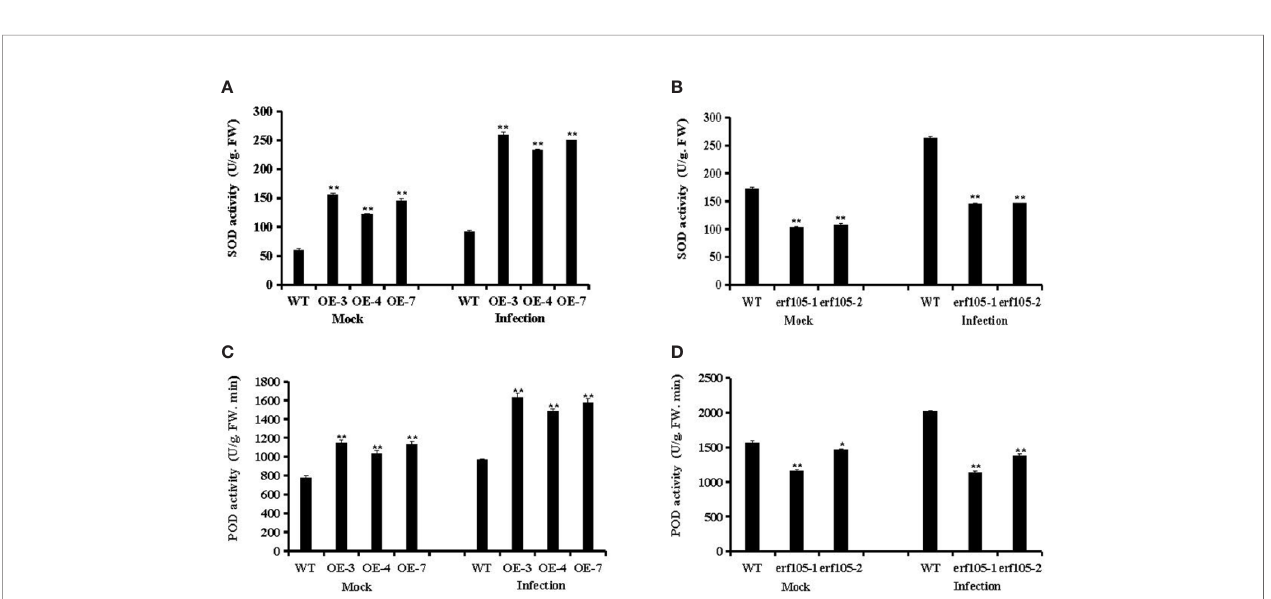
FIGURE 7 | Analysis of antioxidant enzyme activity under mock treatment and infected by E. turcicum at 24-h post-inoculation (hpi). (A, B) The activity of the SOD in ZmERF105 over-expression and erf105 mutant lines, respectively. (C, D) The activity of the POD in ZmERF105 over-expression and erf105 mutant lines, respectively. The activity of the WT sample [mock-treated wild-type (WT) plants] was set to unity. The experiment was performed on three biological replicates, each with three technical replicates, and statistically analyzed using Student ’ s t-test (*P < 0.05, **P < 0.01). Bars indicate standard error of the mean (SE).